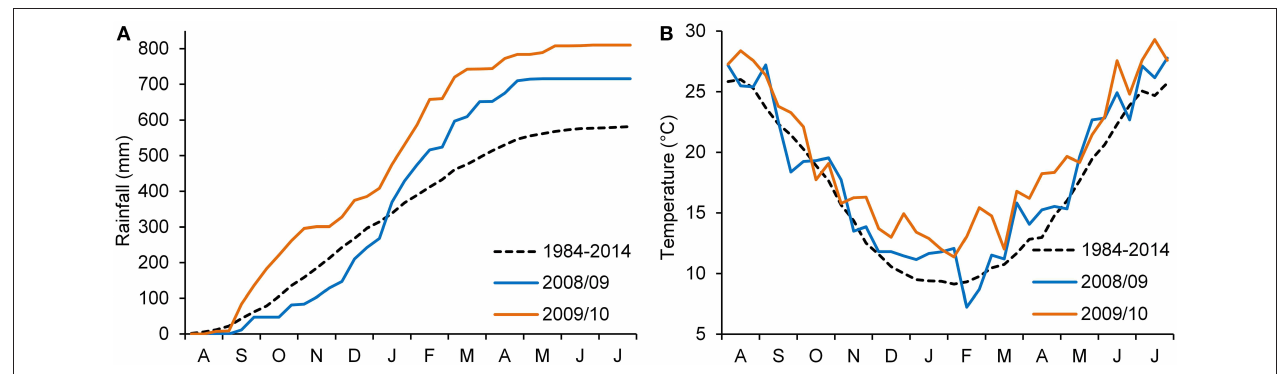
FIGURE 1 | Accumulated rainfall. (A) 10-day mean air temperature (B) at the experimental site during the two growing seasons (2008–2009 and 2009–2010); 30-year average 10-day temperatures and accumulated rainfall are also included.